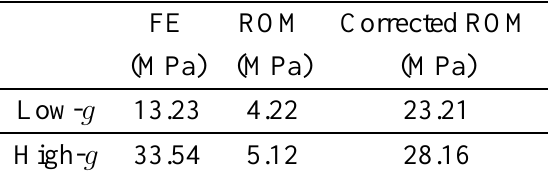
. Comparison among: P